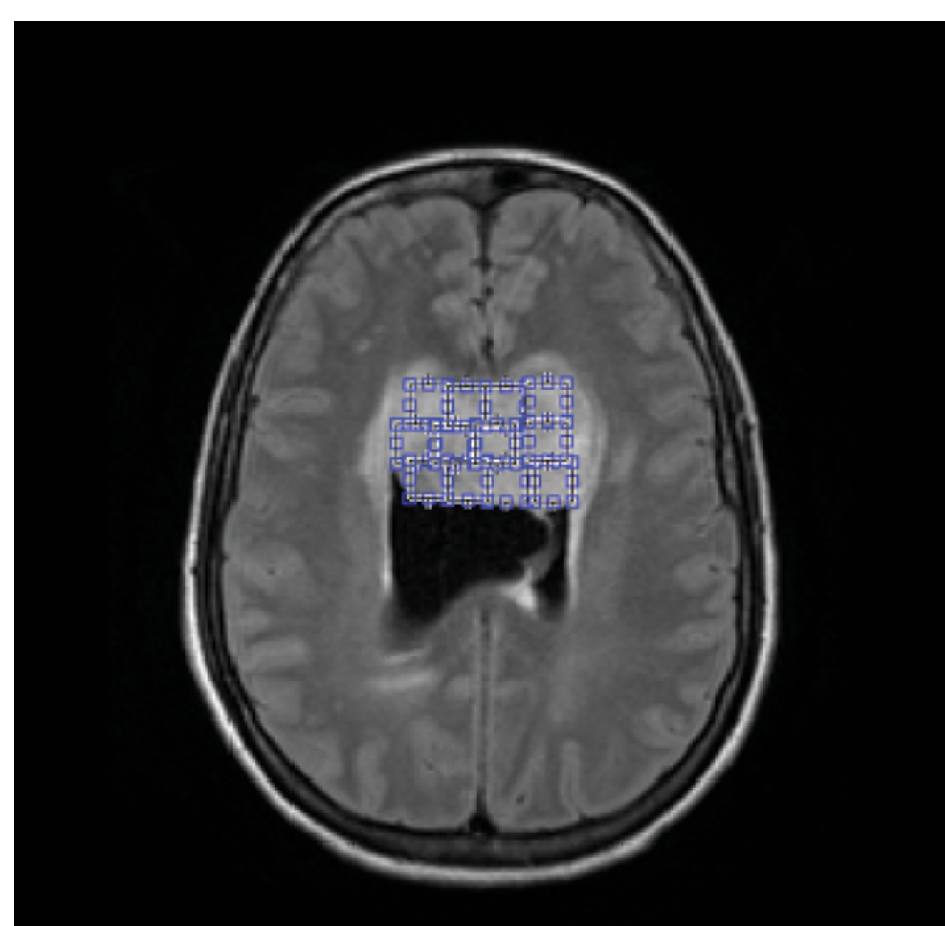
Figure 1. Single slice of a FLAIR weighted image of brain tumor showing the positioning of ROIs within